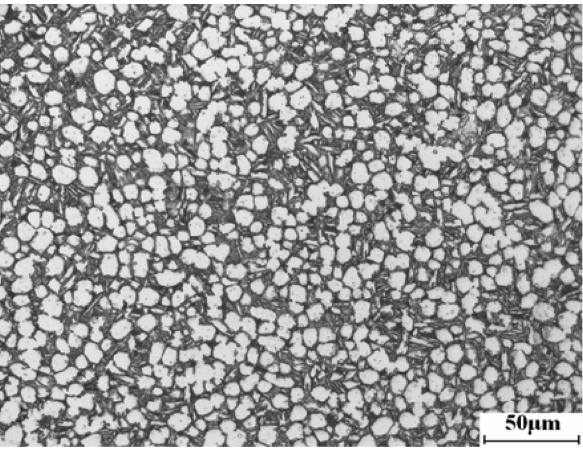
Figure 1: Microstructure of as-received BT25y titanium